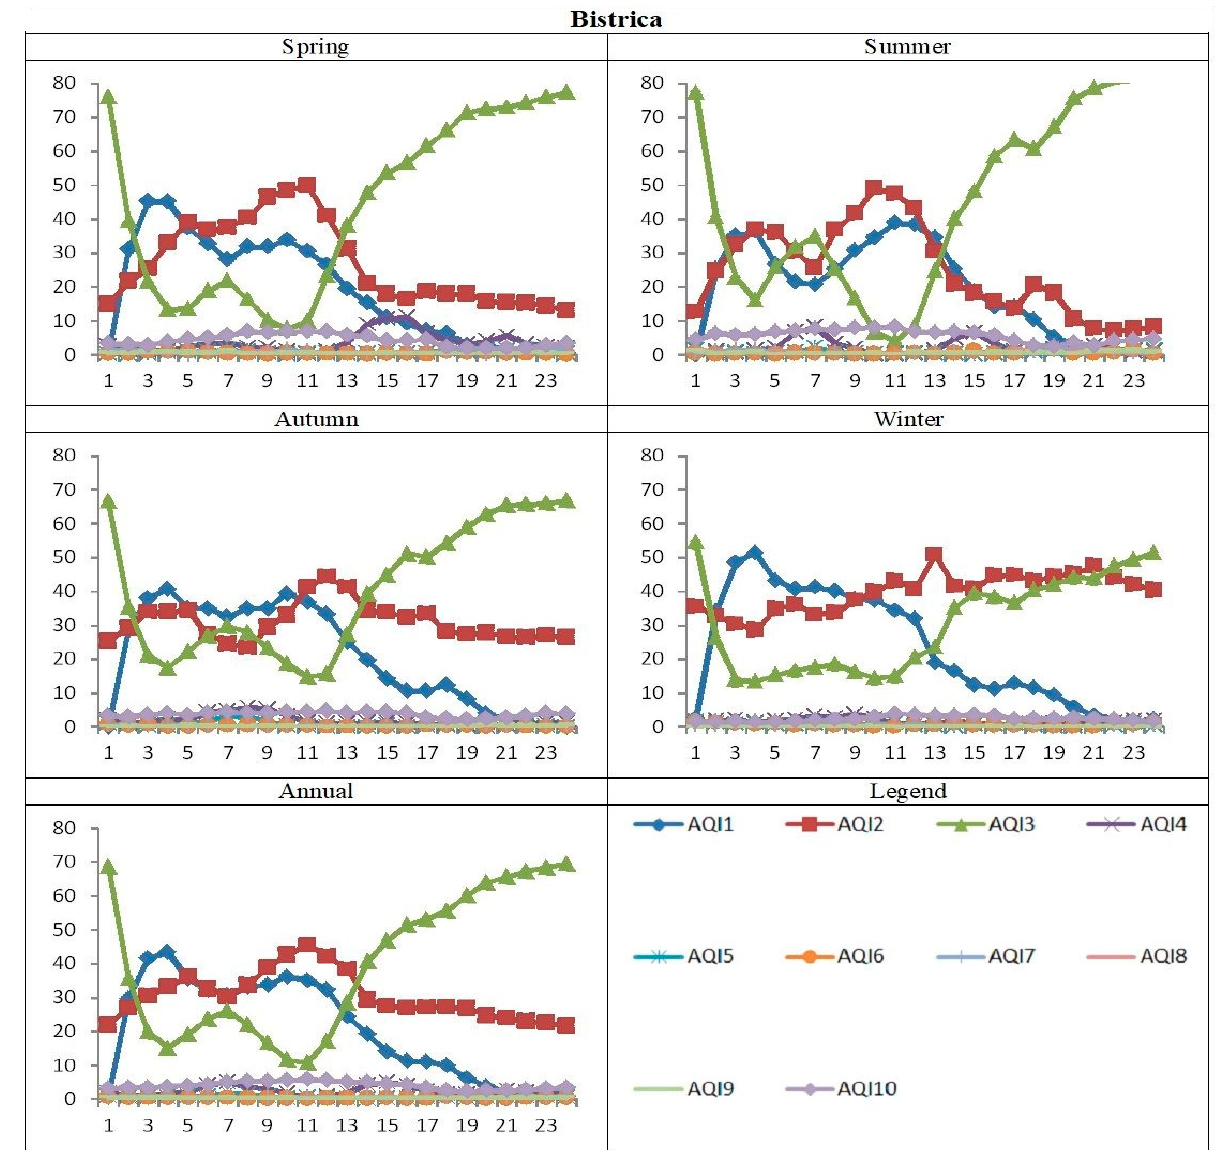
Figure 5. Average recurrence (in %) of the different indices (from 1 to 10) for the Bistrica.